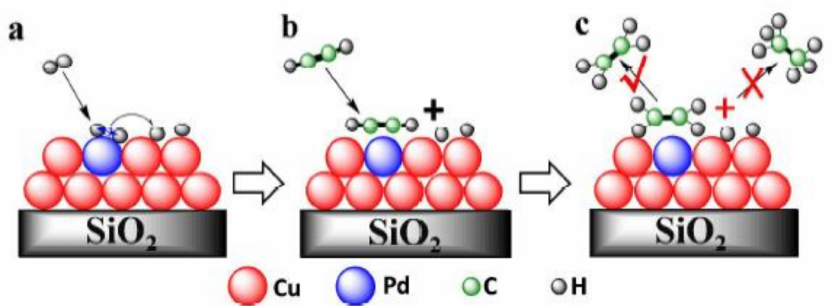
atom catalyst: a —dissociation of H 2 and spillover of H atoms, b —adsorption and hydrogenation of acetylene, c —desorption of ethylene (reproduced with permission from [288]. Copyright 2017 American Chemical